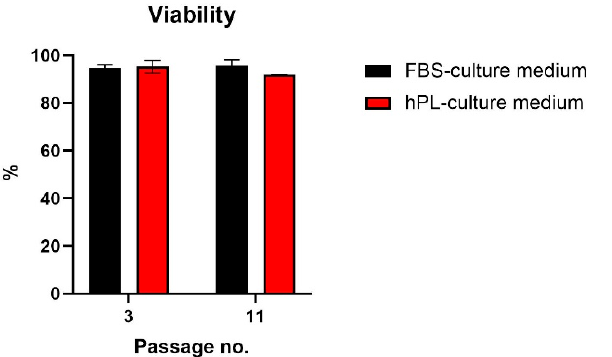
Figure 3. Viability of hNDP-SCs cultivated 2% of hPL or FBS supplement measured in the 3rd and 11th passages. The data are presented as the mean ± SD. The Shapiro–Wilk test or Kolmogorov–Smirnov test were used for normal distribution evaluations. The statistical analysis was calculated using the paired t -test. The difference was not statistically